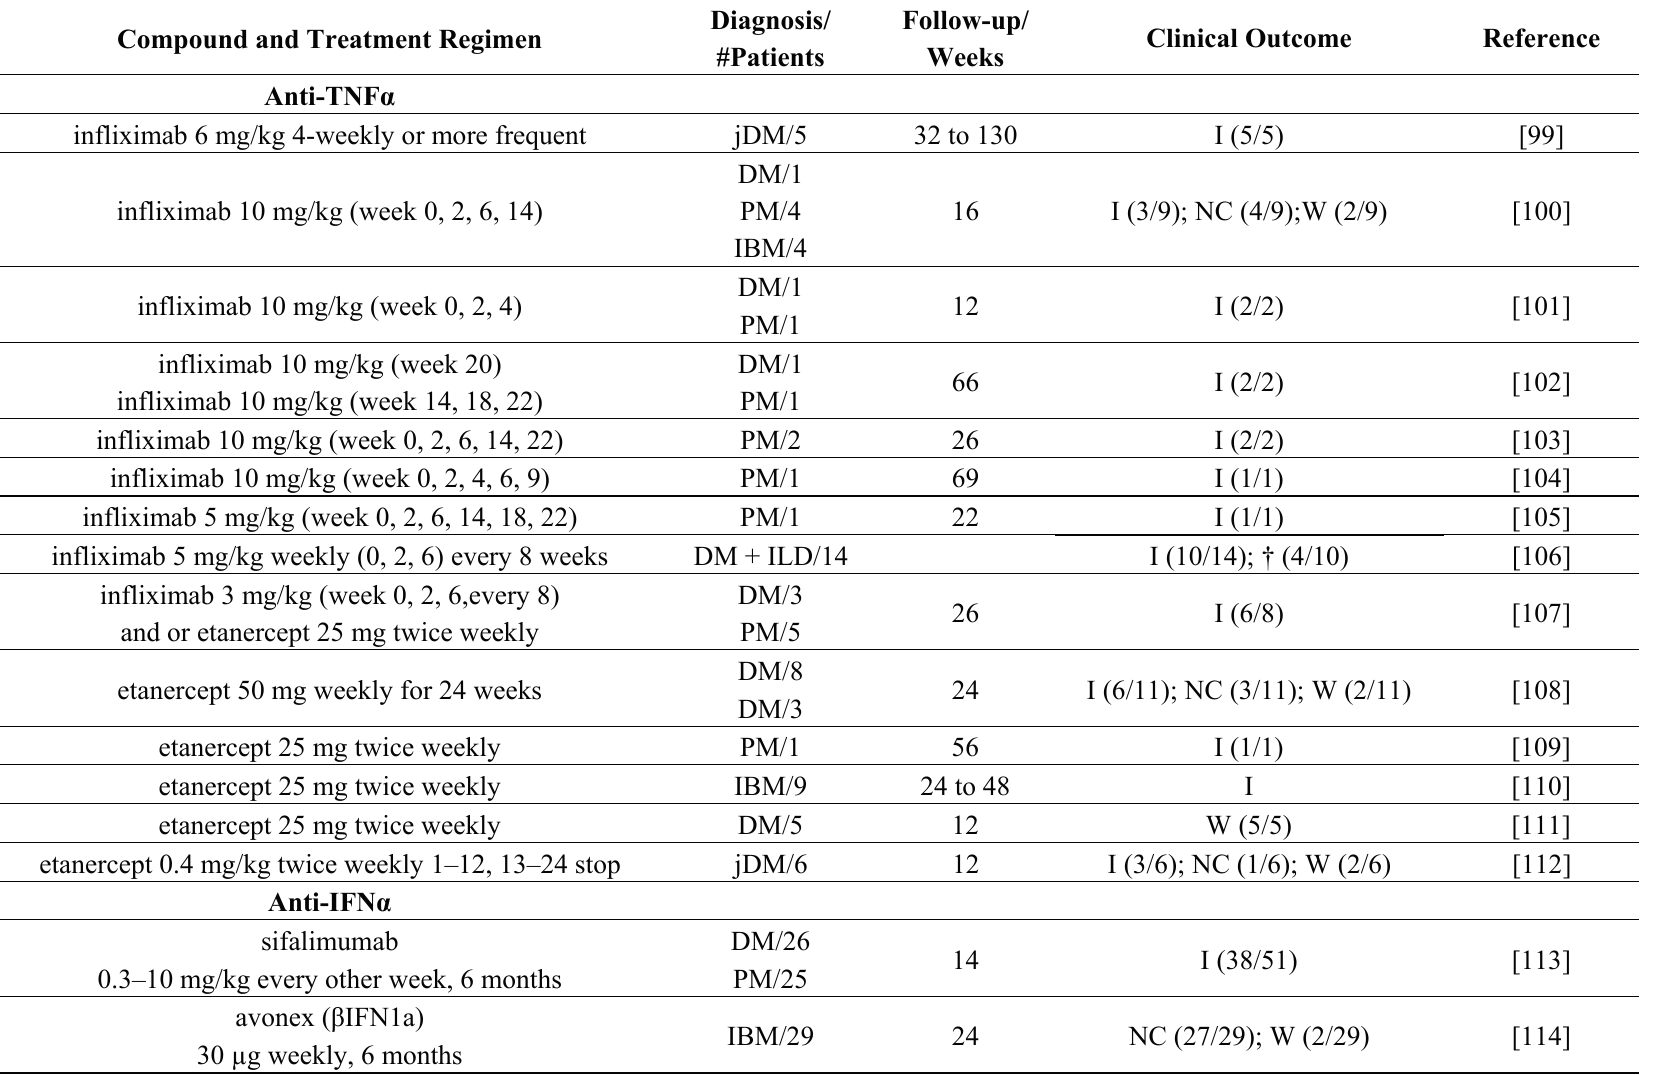
Table 1. Results reported for anti-cytokine agents in refractory idiopathic inflammatory